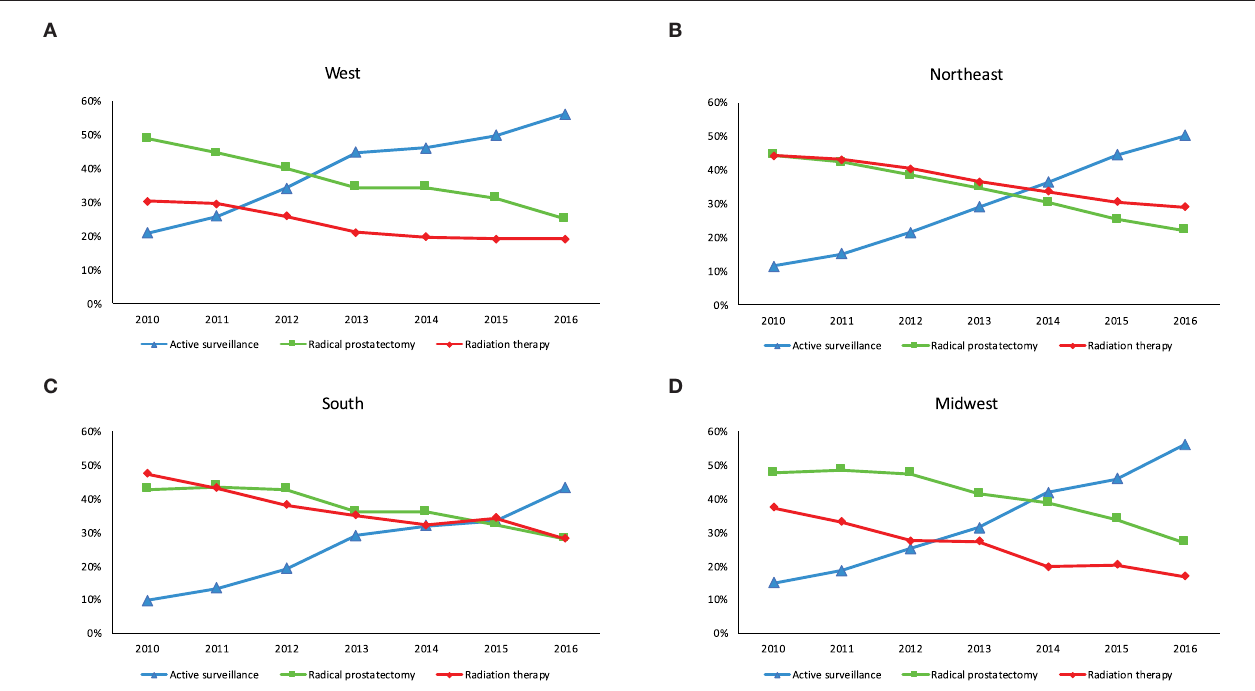
FIGURE 1 | Management of men with low-risk prostate cancer in each US census region between 2010 and 2016. (A) West (B) Northeast (C) South and (D) Midwest.